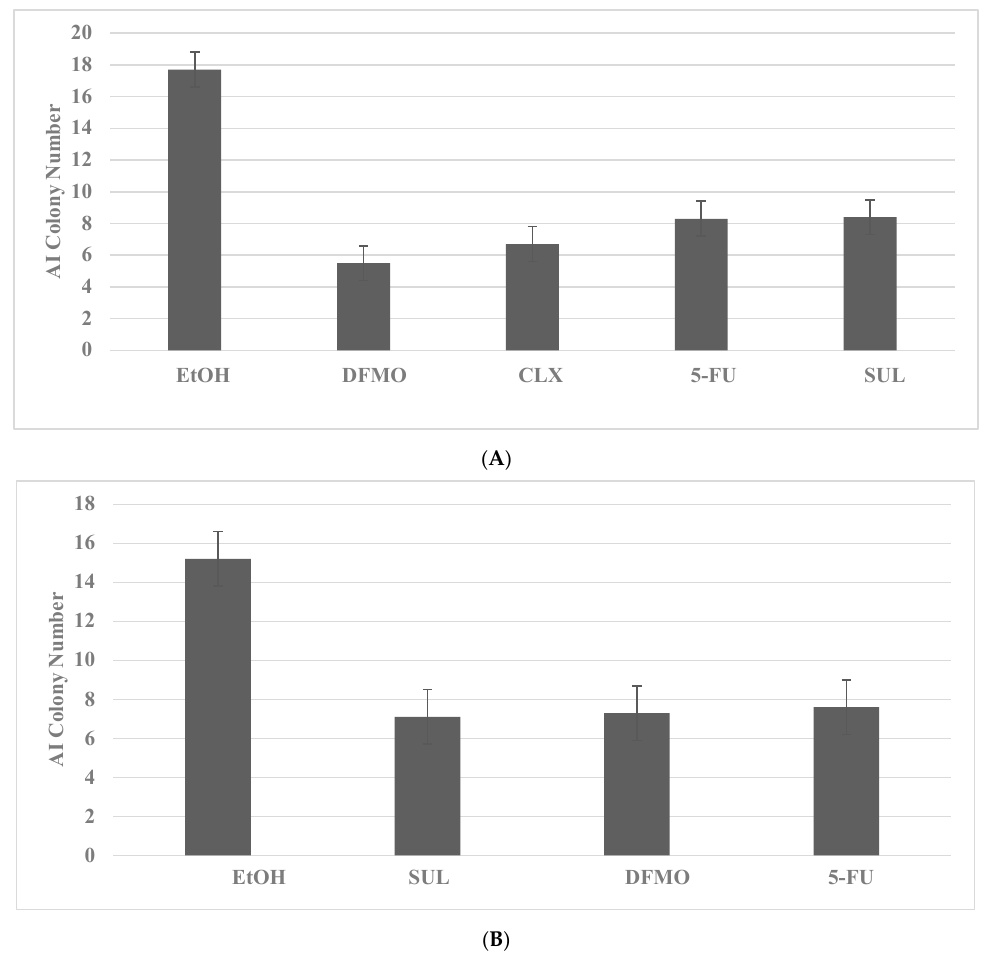
Figure 1. Growth inhibitory effects of pharmacological agents on colon cancer models. ( A ) Reduction in AI colony number by treatment with DFMO, CLX, 5-FU and SUL in the FAP model for colon cancer. EtOH versus DFMO and CLX p = 0.038; EtOH versus 5-FU and SUL p = 0.04. ( B ) Reduction in AI colony number by treatment with SUL, DFMO and 5-FU in the HNPCC model. EtOH versus SUL and DFMO p = 0.037; EtOH versus 5-FU p = 0.04. Data analyzed by ANOVA with Dunnett’s multiple comparison post-hoc test. AI, anchorage independent; EtOH, ethanol; DFMO, difluoromethyl ornithine; CLX, celecoxib; 5-FU, 5-fluoro-uracil; SUL, sulindac.